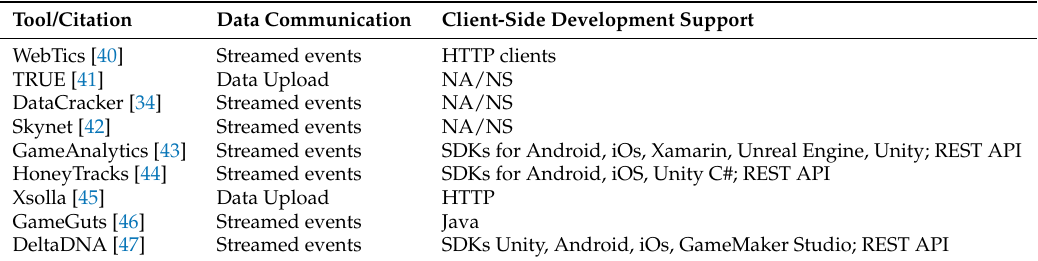
Table 3. Comparison of data collection and communication related features among academic and commercial tools for game analytics. NA/NS = Not Applicable, Not Specified or